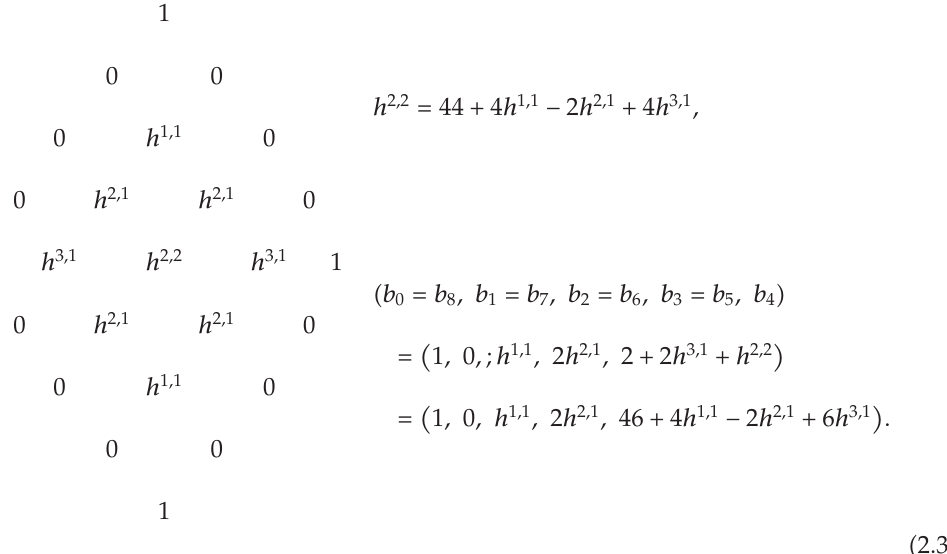
Kreuzer-Skarke (cid:3) 27, 48 (cid:4) . Now, there are, totaling the hypersurfaces in toric fivefolds,